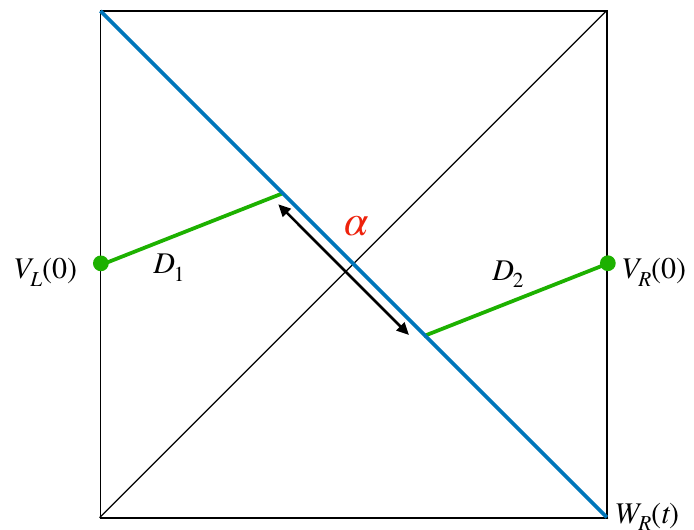
Figure 3 . The geodesic (green) connecting the operators V L (0) and V R (0) in the shockwave geometry (2.15) created by the operator W R ( t ). Due to the shockwave (blue) the geodesic is shifted by an amount (cid:11) along the past